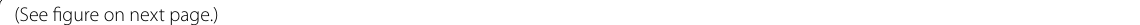
Fig. 2 Determination of affinity constants ( K D ) of immobilized anti‑OTA antibodies against OTA and switching peptides using SPR biosensor. a Covalent immobilization of anti‑OTA antibody to the modified surface of SPR chip. b SPR sensorgram for the treatments of OTA and dose–response curve from SPR measurements at different concentrations of OTA against anti‑OTA antibody. c SPR sensorgrams at different concentrations of switching peptides using immobilized anti‑OTA antibodies and calculation of affinity constants ( K D ) for each switching peptide against the same anti‑OTA